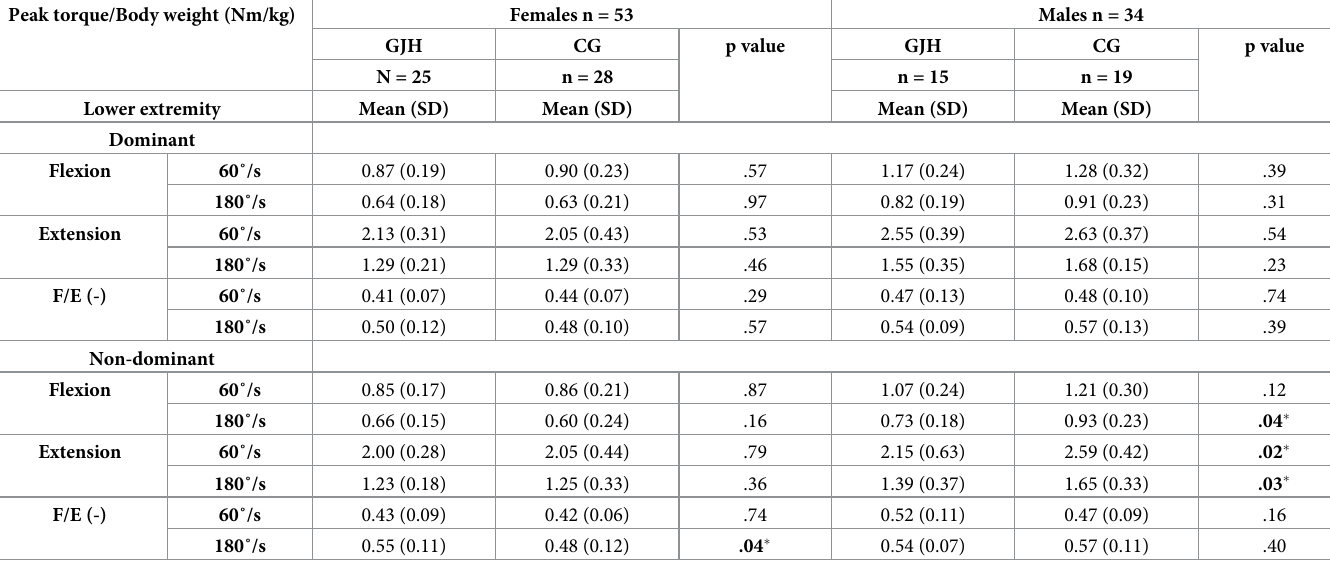
Table 4. The comparison of peak torque under isokinetic conditions obtained by females and males with and without generalized joint hypermobility. Peak torque/Body weight